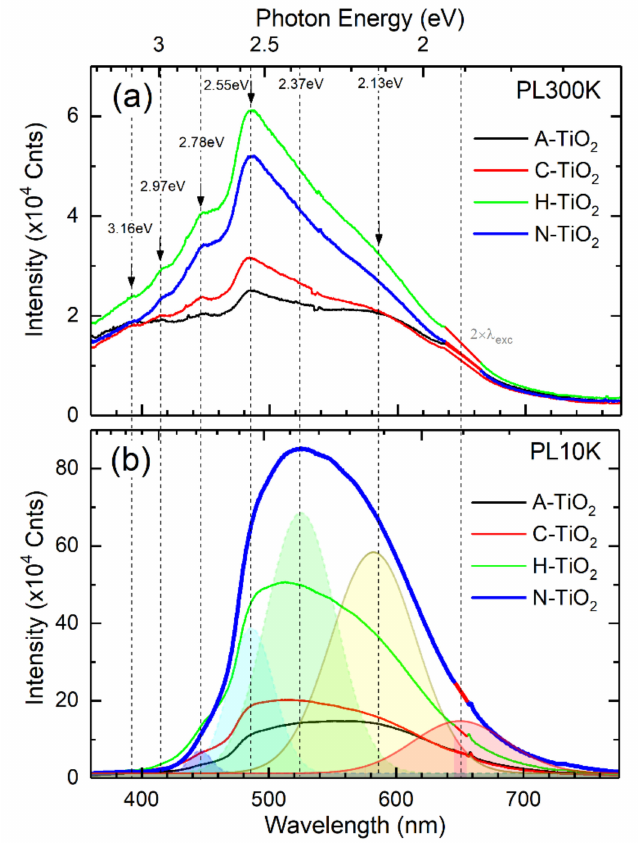
Figure 5. Optical emission properties of the TiO 2 powders: PL spectra measured in vacuum at 300 K ( a ) and 10 K ( b ). The key emission components are indicated by Gaussian deconvolution curves/shaded areas.